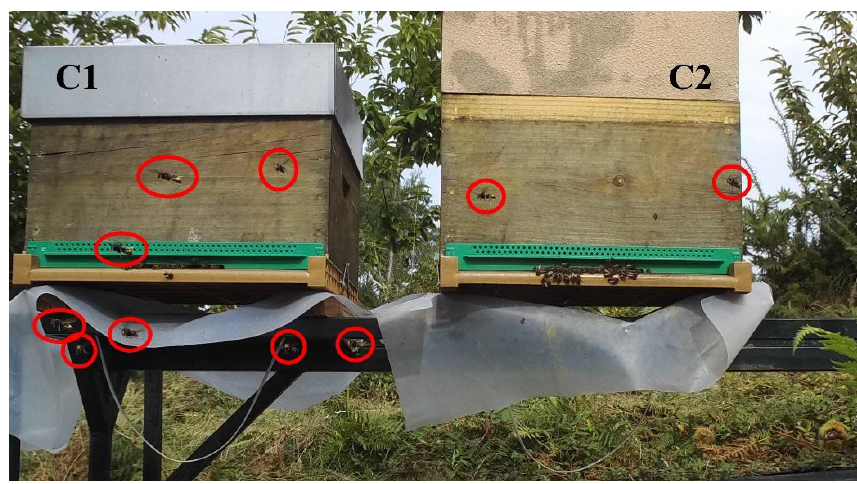
Figure 5. Hornets’ sightings marked with red circles in front of the two beehives. C1 on the left and C2 on the right. The picture was taken on 16 September 2020, at 16:00 h.